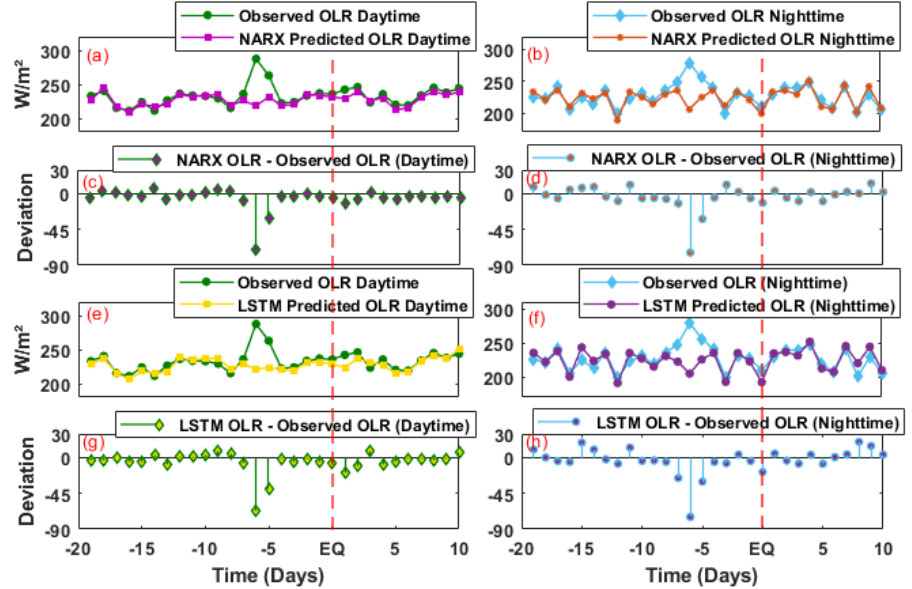
Figure 3. ( a ) Time series data variations between the observed OLR daytime values and NARX- predicted OLR daytime values, ( b ) Nighttime variations between the observed OLR values and NARX-predicted OLR, ( c ) Deviation of NARX-predicted OLR daytime values from the observed daytime OLR values, ( d ) Deviation of NARX-predicted OLR nighttime values from the observed nighttime OLR values, ( e ) Time series data variations between the observed OLR daytime values and LSTM train OLR daytime values, ( f ) Nighttime variations between observed OLR values and LSTM train OLR, ( g ) Deviation of LSTM-predicted OLR daytime values from Observed daytime OLR values, ( h ) Deviation of LSTM-predicted OLR nighttime values from Observed daytime OLR values. The red dashed line shows earthquake day.